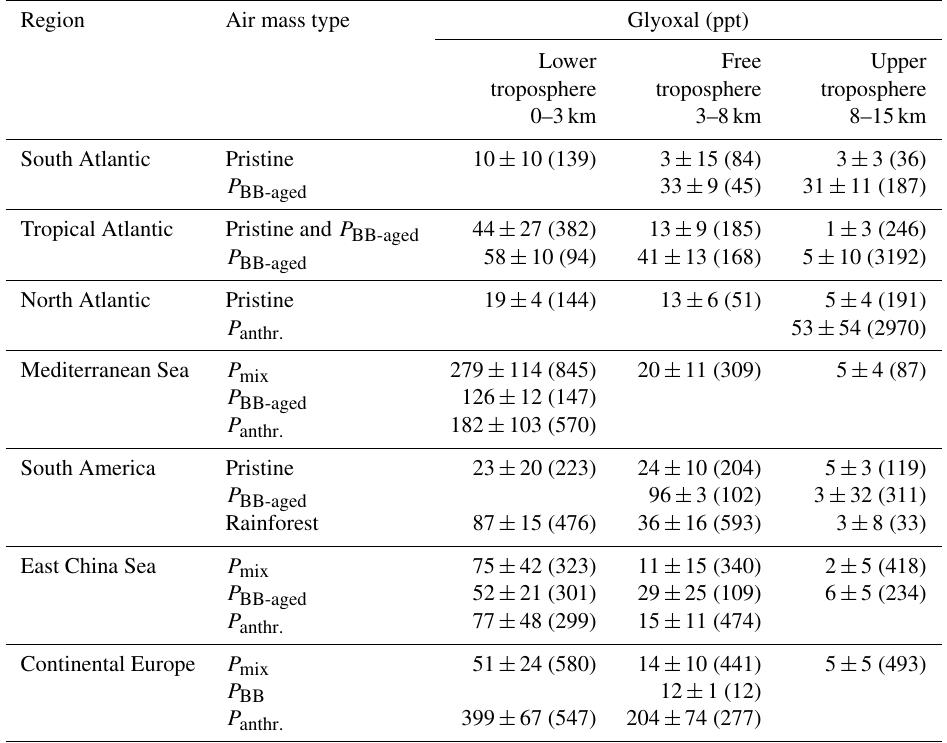
Table 3. Observed median, median absolute deviation, and maximum (in parentheses) glyoxal mixing ratios (ppt) as a function of different geographic regions, air mass types, and altitude ranges. If available, chemical markers are used for the attribution of the air masses to the different regimes. Polluted air masses are differentiated into fresh or aged biomass burning ( P BB-fresh/aged or P BB , in cases where the plume age is not known), anthropogenic pollution ( P anthr . ), and mixed pollution ( P mix ). Further categories consist of air masses rich in biogenic volatile organic compound (bVOC) emissions (labelled “Rainforest”) and pristine